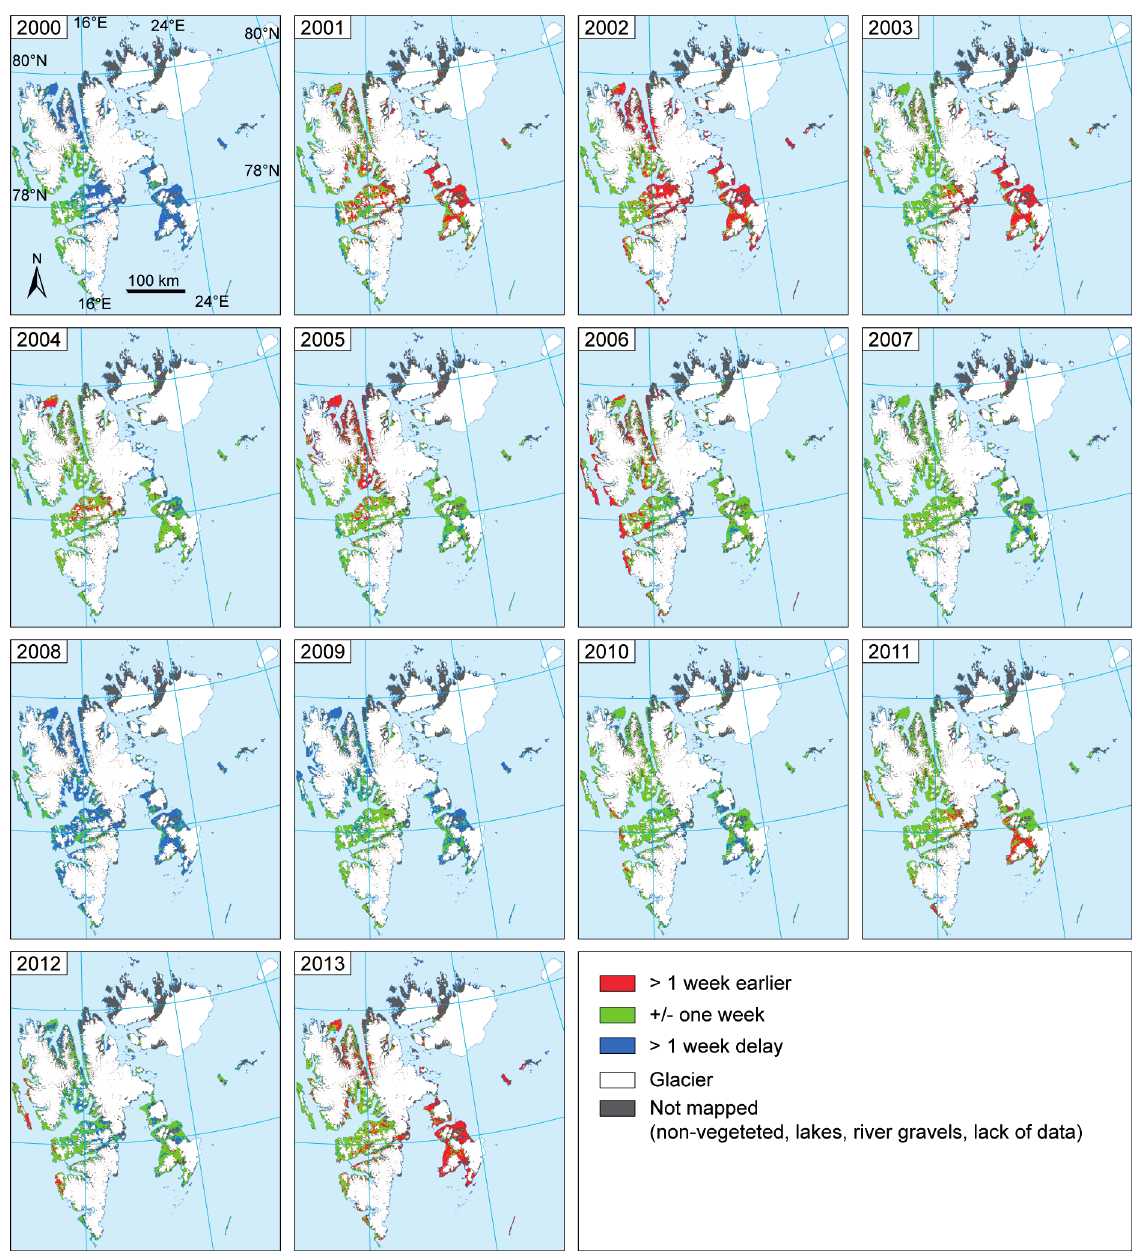
Figure 7. Regional variation in onset of the growing season from the 2000–2013